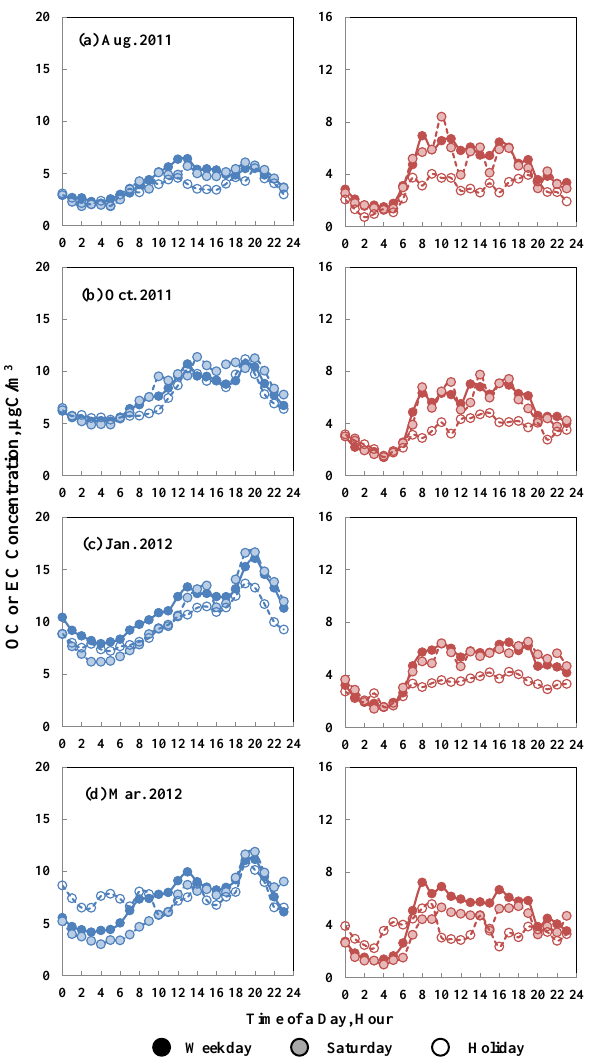
Figure 3 . Diurnal variations of OC (blue dots) and EC (red dots) concentrations (unit: Figure 3. Diurnal variations of OC (blue dots) and EC (red dots) concentrations (unit: µgCm − 3 ) for weekdays, Saturdays and holi- μ gC/m 3 ) for weekdays, Saturdays and holidays at MK AQMS in (a) August 2011, (b) days at MK AQMS in (a) August 2011, (b) October 2011, (c) Jan- uary 2012 and (d) March 2012.